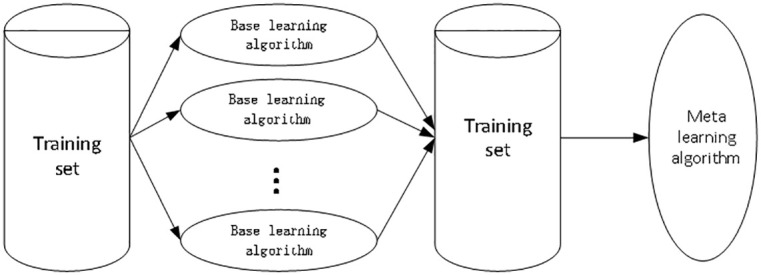
Principle of stacking algorithm.